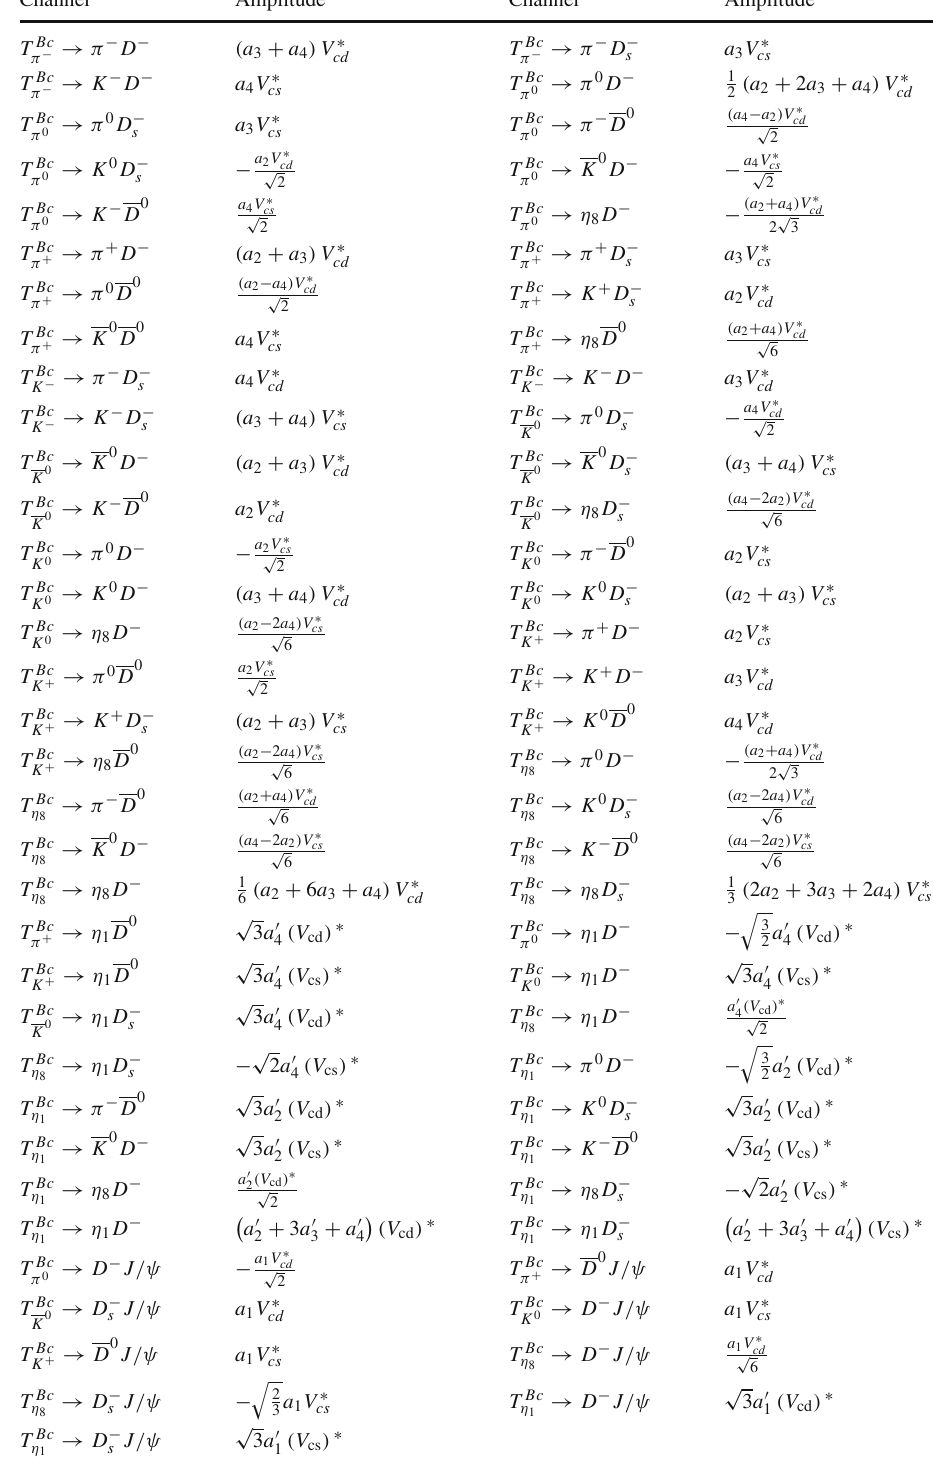
Table 3 Tetraquark T b ¯ c 8 / T b ¯ c 1 decays into anti-charmed meson plus light meson or anti-charmed meson plus J